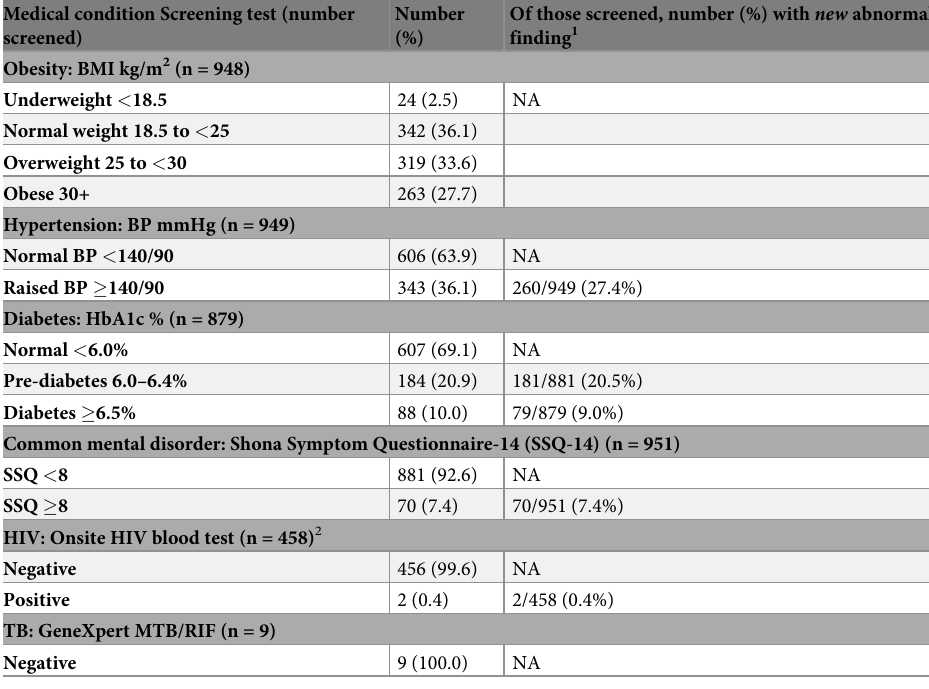
Table 3. Prevalence of chronic diseases identified by screening health care workers. Medical condition Screening test (number screened)